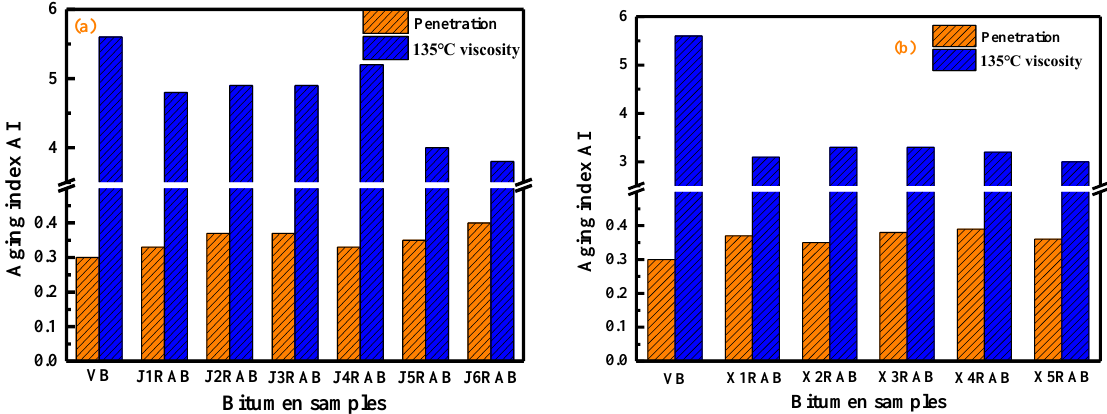
Figure 11. The aging index AI of virgin and rejuvenated binders after long-term